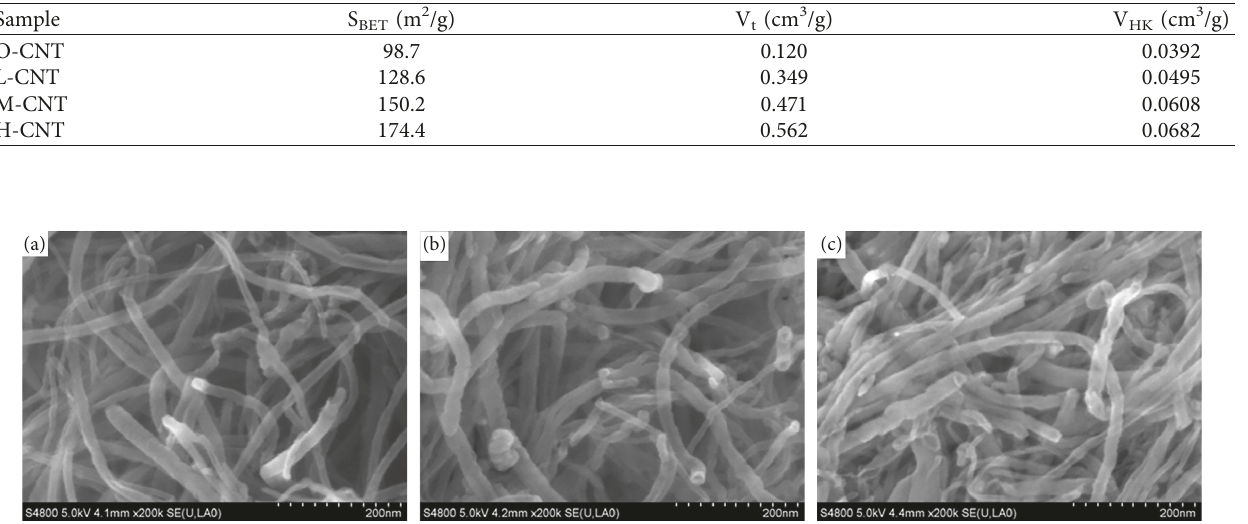
Figure 2: SEM images of L-CNT (a), M-CNT (b), and H-CNT (c).